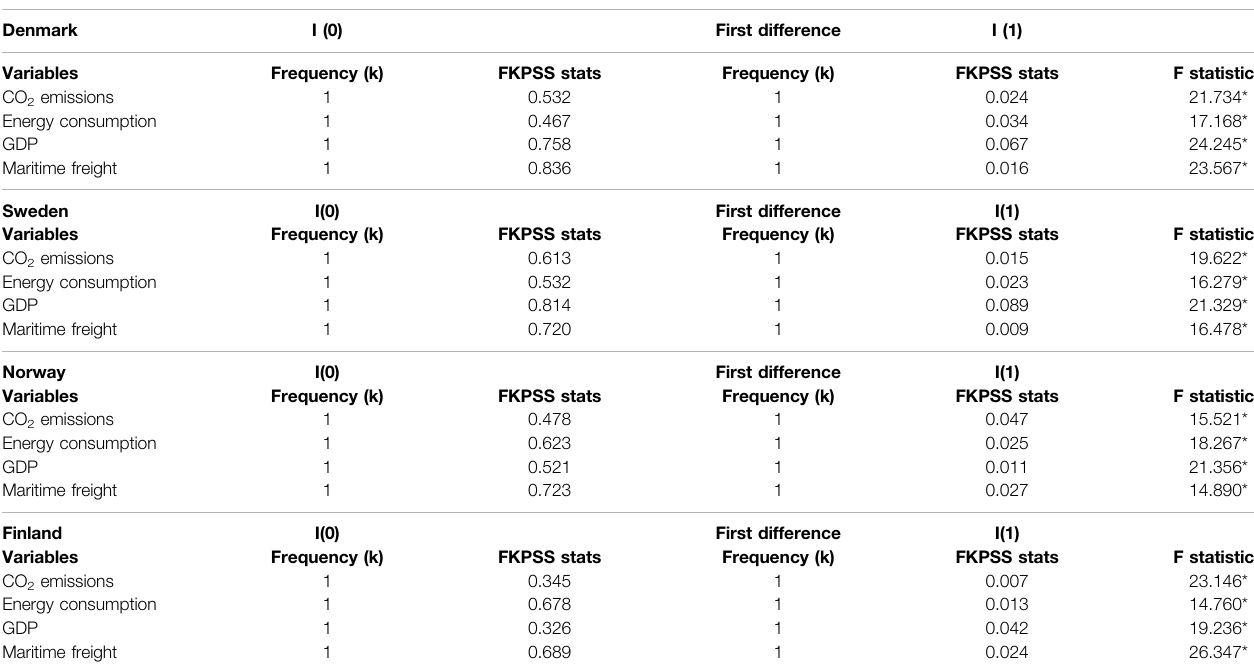
TABLE 5 | FKPSS stationary test